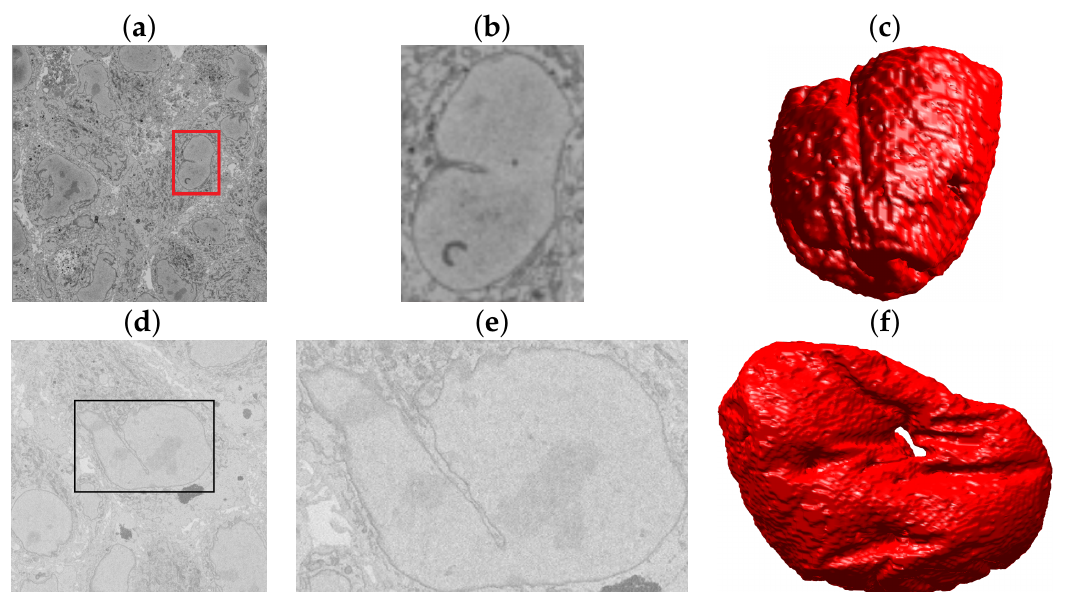
Figure 13. Illustration of the Serial Block Face Scanning Electron Microscope (SBF SEM) images containing monolayers of Chlamydia trachomatis-infected HeLa cells. ( a ) A representative image from the Cell Image Library CIL 50051 dataset. The volume has 3200 × 3200 × 413 voxels, and the voxel size is 3.6 × 3.6 × 60 nm. ( b ) An ROI with one nucleus, which corresponds to the red box in ( a ). ( c ) Rendering of the NE of this cell. ( d ) One representative image from the Cell Image Library CIL 50061 dataset. The set has 2435 × 2489 × 406 voxels and a voxel size 8.6 × 8.6 × 60 nm. ( e ) An ROI with one nucleus corresponding to the black box in ( d ). ( f ) Rendering of the NE of this cell.